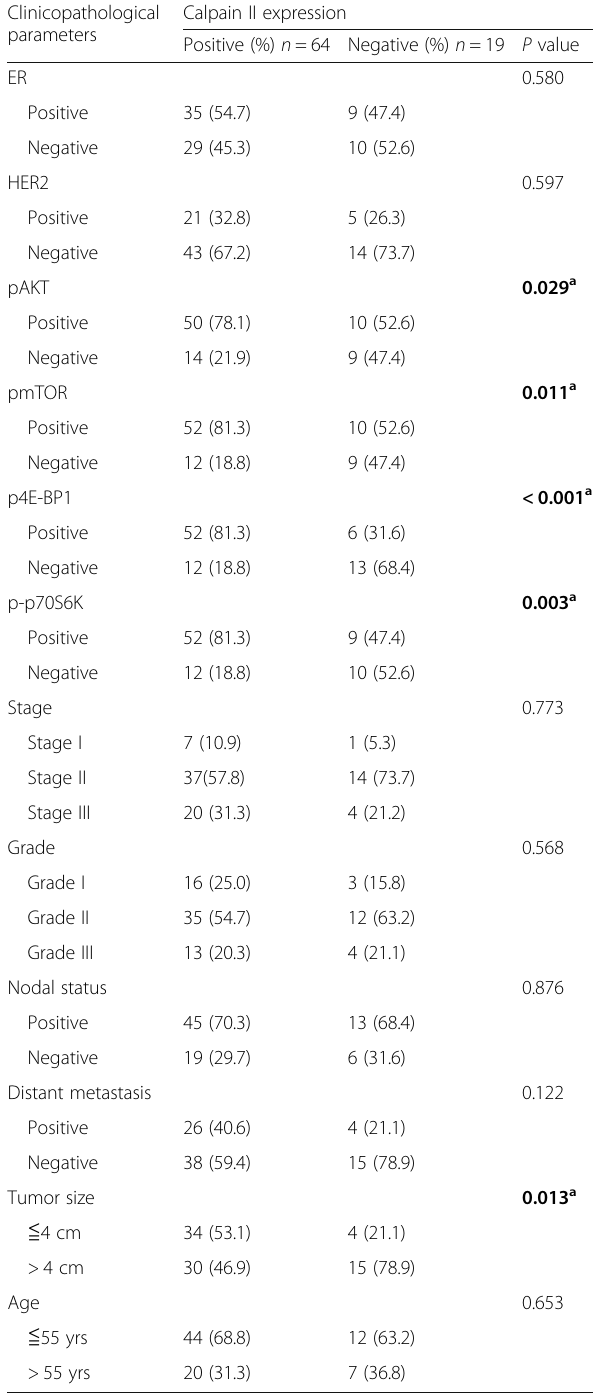
Table 3 The correlation between calpain II expression and clinicopathological parameters in IDC cases Clinicopathological